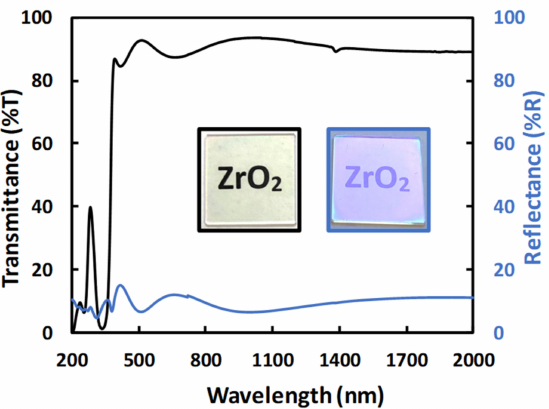
Figure 2. UV–Visible-NIR transmittance (in blue) and reflectance (in black) spectra of ZrO 2 xerogel thin film deposited on SiO 2 substrate. Inset: black and blue represent optical photographs of the ZrO 2 layers in transmission and specular reflection,